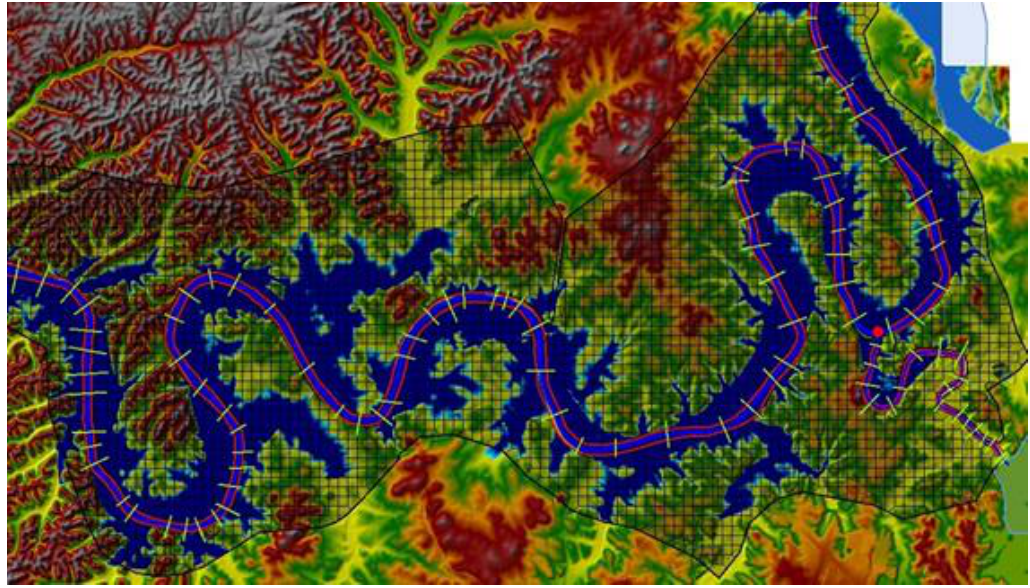
Figure 8. Simulated inundation map using combined one- and two-dimensional approach in HEC- RAS for the May 2010 flood event.